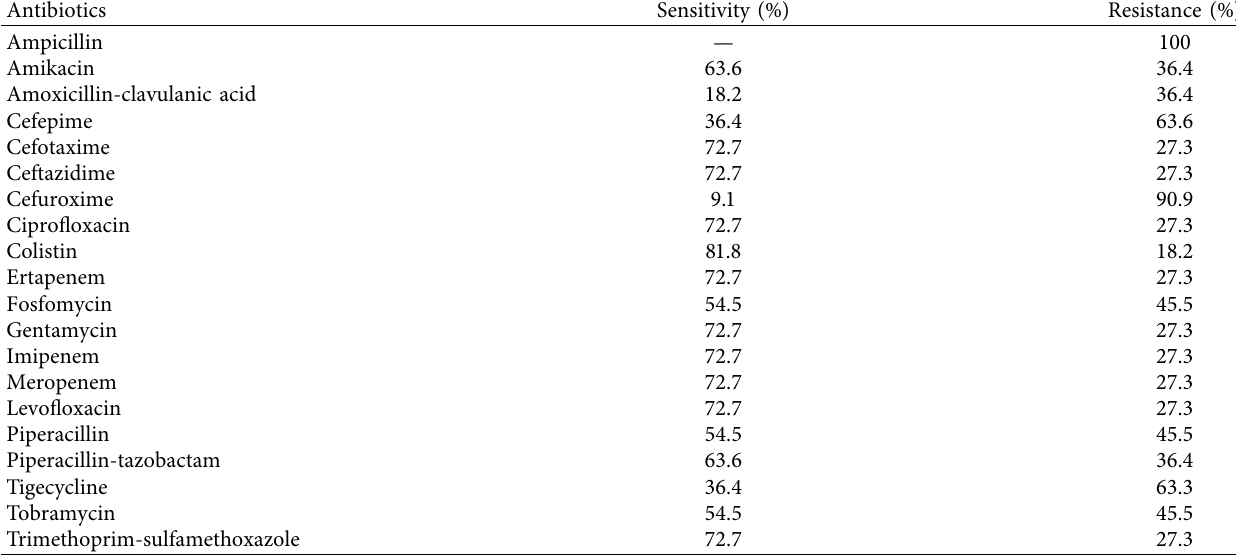
Table 5: Sensitivity and resistance of Gram-negative